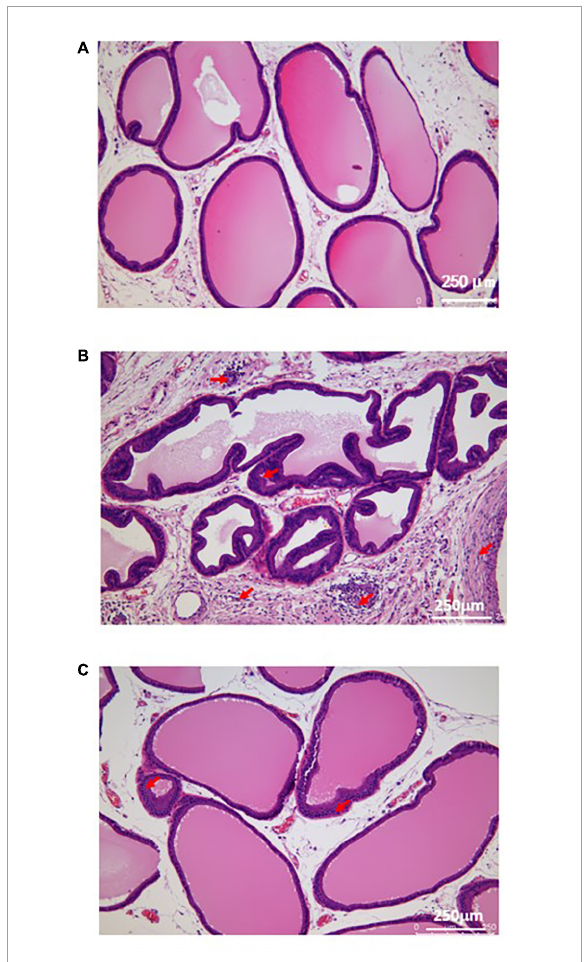
FIGURE2 Histological morphology of prostatic tissue in each group. (A) The result of H&E staining in sham group; (B) The result of H&E staining in model group; (C) The result of H&E staining in EA group. Red arrows show the infiltration of inflammatory cells.